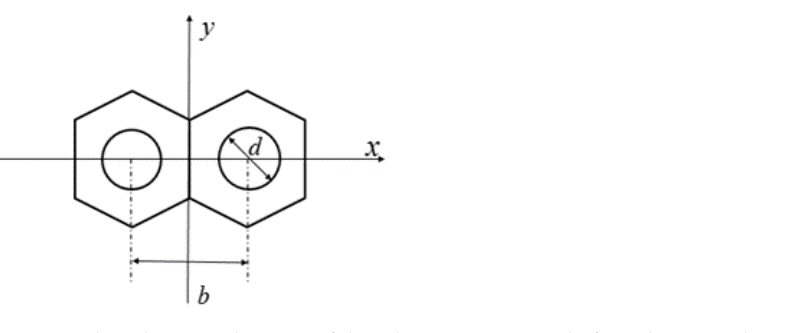
Figure 1. The schematic diagram of the telescope composed of two hexagonal segments with sparse circles configuration.